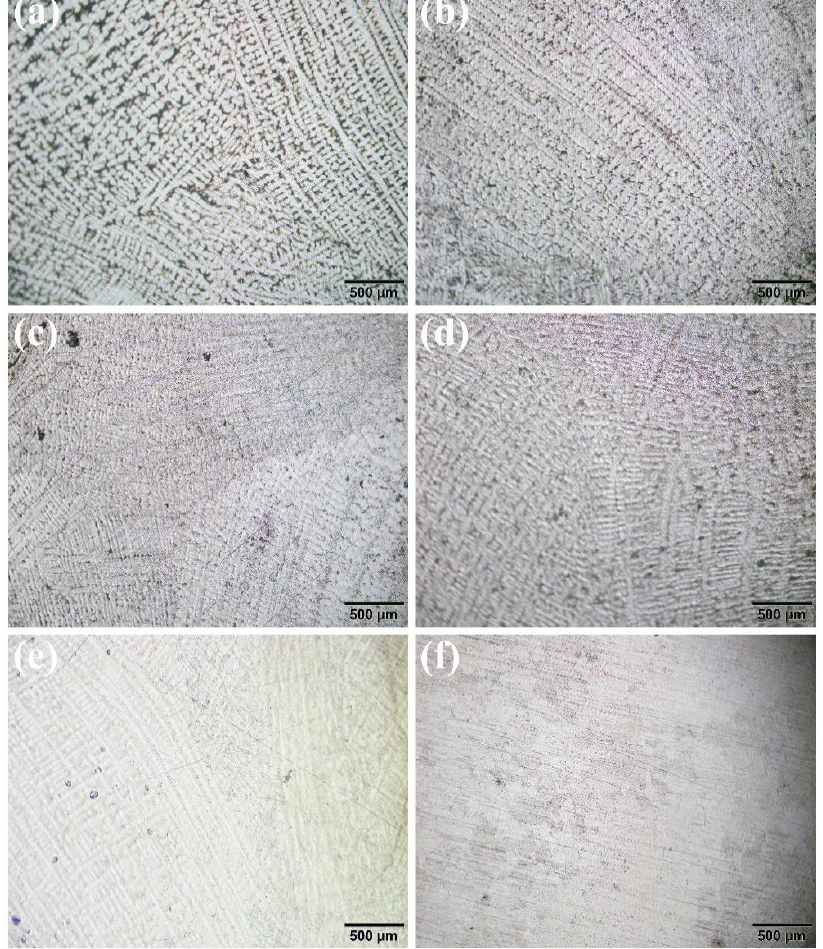
Figure 9. Optical microstructures of SJTU-1 alloy deformed with strain rate 0.001 s −1 at ( a ) 900